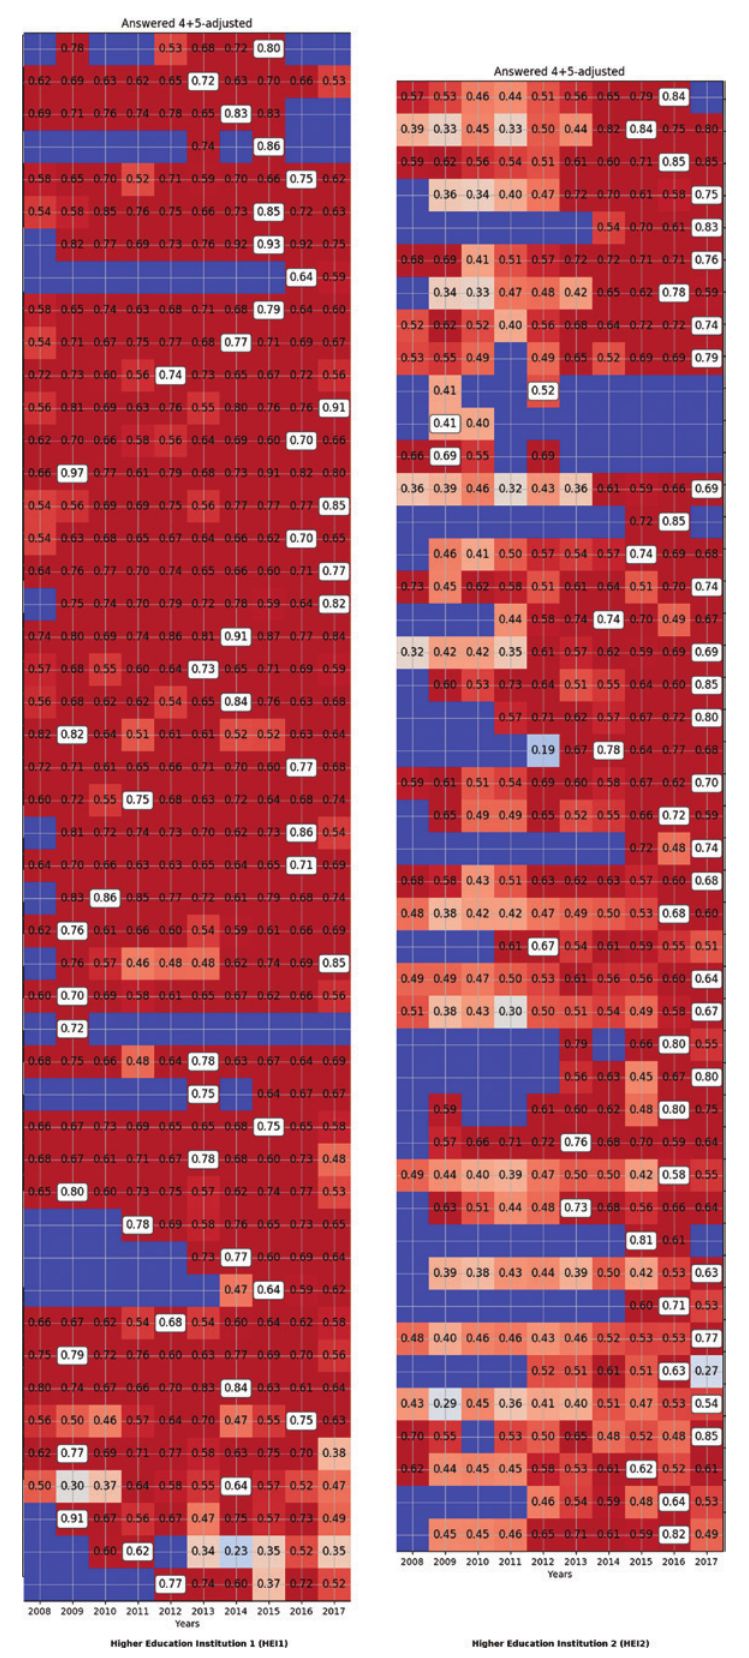
Figure 12: Comparison of when highest scores occur, per subject, in different